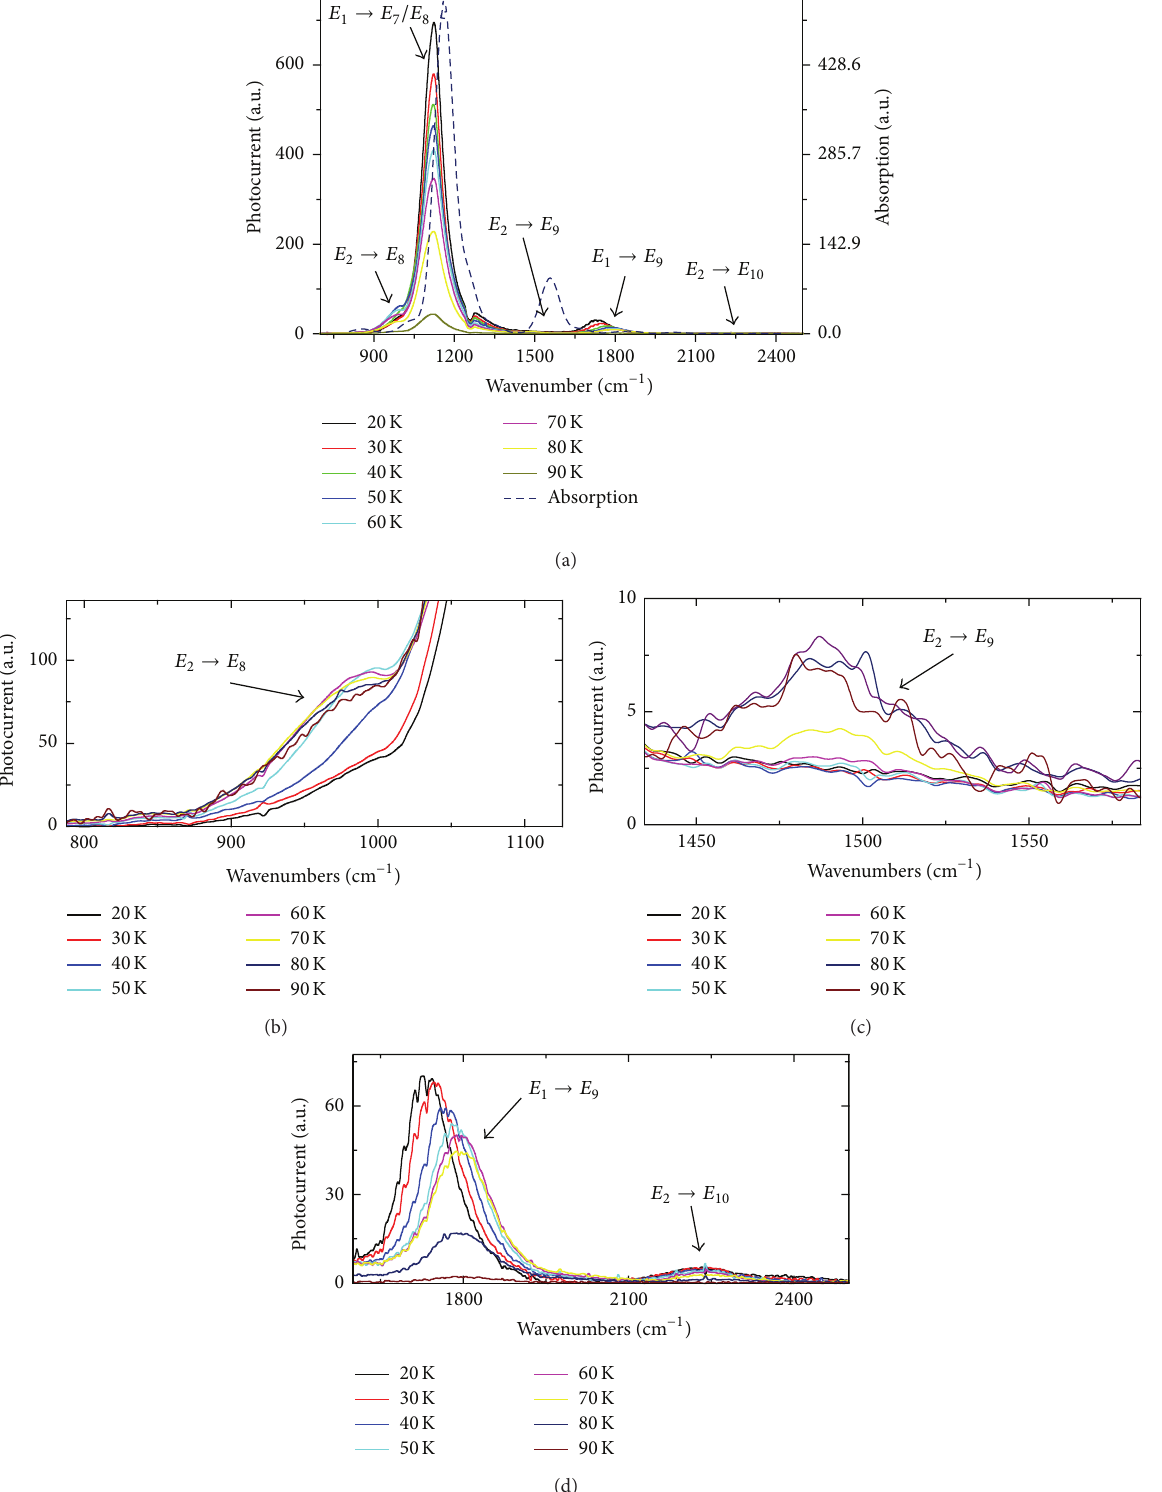
Figure 2: (a) Calculated absorption spectra at 300 K (dashed line) and measured photoresponse spectra (solid line). (b) Details (normalized) around 𝐸 2 → 𝐸 8 . (c) Details (normalized) around 𝐸 2 → 𝐸 9 . (d) Details around 𝐸 1 → 𝐸 9 and 𝐸 2 → 𝐸 10